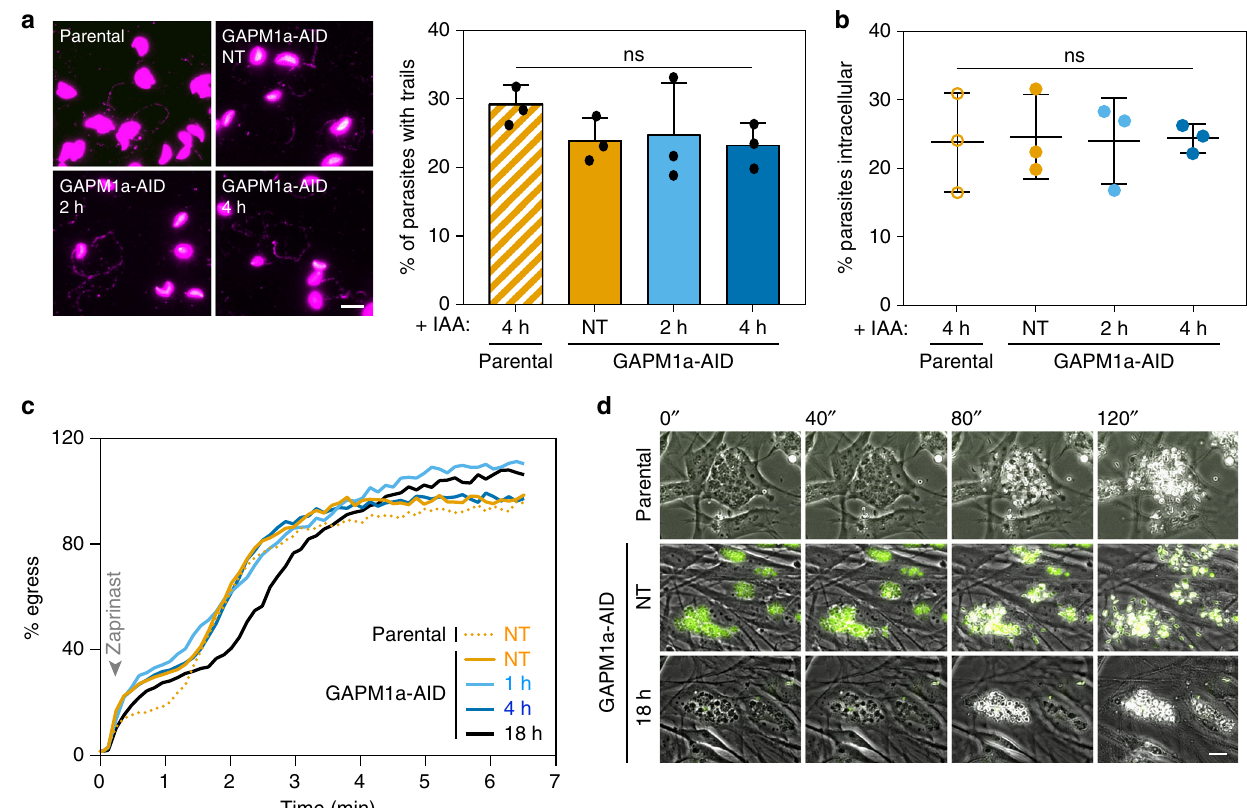
Fig. 3 Acute depletion of GAPM1a does not inhibit 2D gliding, invasion, or egress. a 2D gliding motility assayed by trail deposition, visualised with anti- SAG1 using the parental line or GAPM1a-AID parasites after treatment with IAA for 2 or 4 h. Graph represents mean ± SD for n = 3 independent experiments; ns p > 0.05, Student ’ s t test. Scale bar is 10 μ m. b Depletion of GAPM1a for up to 4 h had no effect on invasion. All IAA treatments were performed on intracellular parasites, prior to mechanical release and incubation with fresh monolayers for 1 h. The percentage of parasites that were intracellular was quanti fi ed. Each point represents the average invasion from one well. Graph represents mean ± SD for n = 3 independent experiments; ns p > 0.05, Student ’ s t test. c Zaprinast-induced egress measured as the percent of host cells permeabilized over time. The number of DAPI-positive host-cell nuclei was calculated by automated image analysis. Results are the mean of three wells and representative of two independent experiments. d Video microscopy of zaprinast-induced egress; representative frames are shown. Parasites depleted of GAPM1a-AID overnight lysed the host cells, despite remaining immobile and unable to reinvade for the course of the experiment. Scale bars are 10 µ m. Source data are provided as a Source Data fi